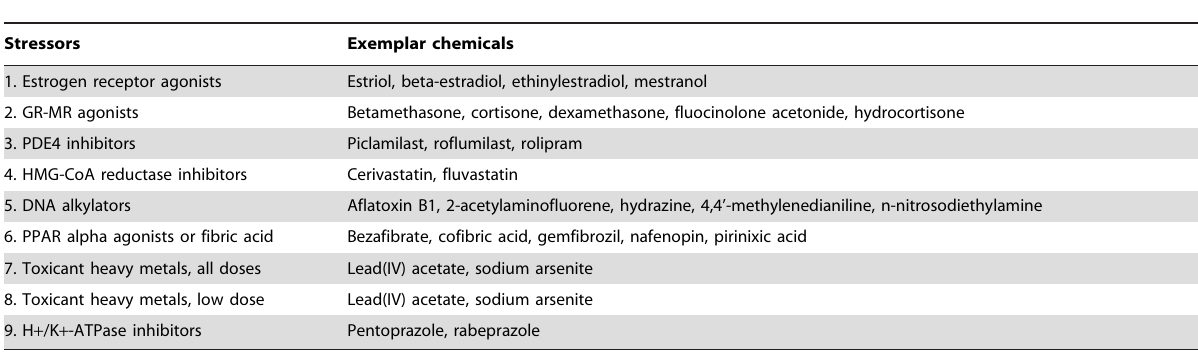
Table 2. DrugMatrix [21,22] structure-activity classified drugs and toxicants.